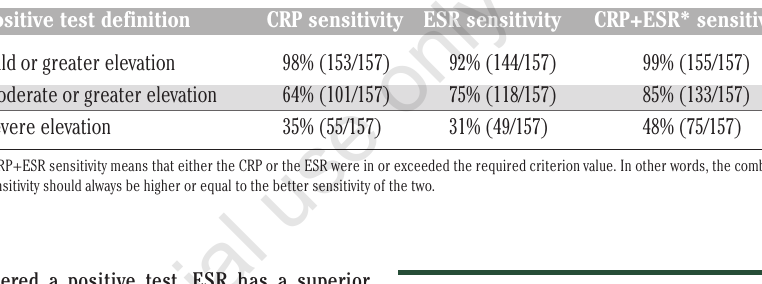
Table 2. Sensitivity of C-reactive protein and erythrocyte sedimentation